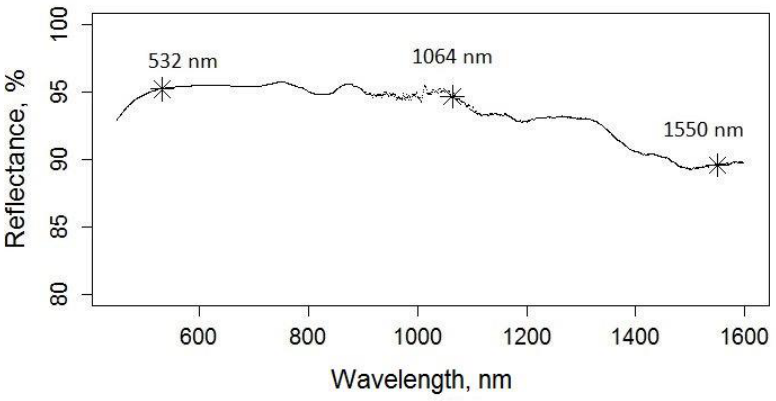
Figure 4. Spectral reflectance curve for the constructed targets.